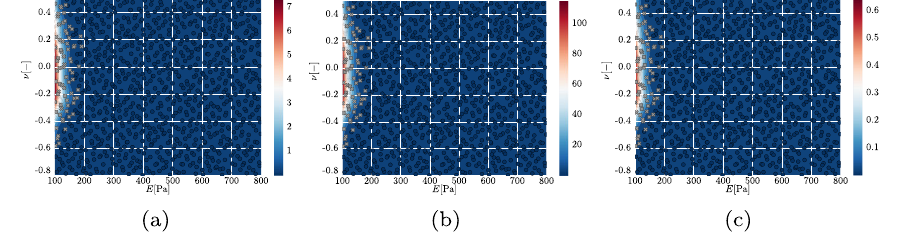
Fig. 7 Standard deviation from logarithmic likelihood regression model variance for different surface measure distances with n train = 1000. a Euclidean distance at measurement points, b closest point projection distances, c RKHS norm. Training samples as circles for successful and gray crosses for failed forward model